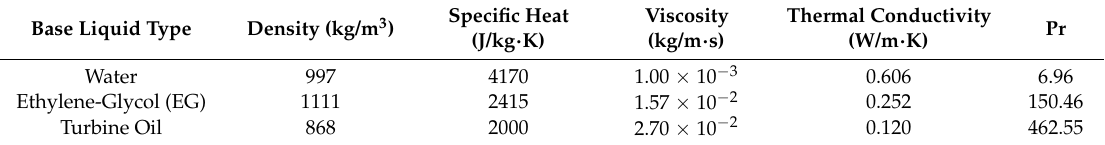
Table 3. Thermophysical properties of different base liquid types.